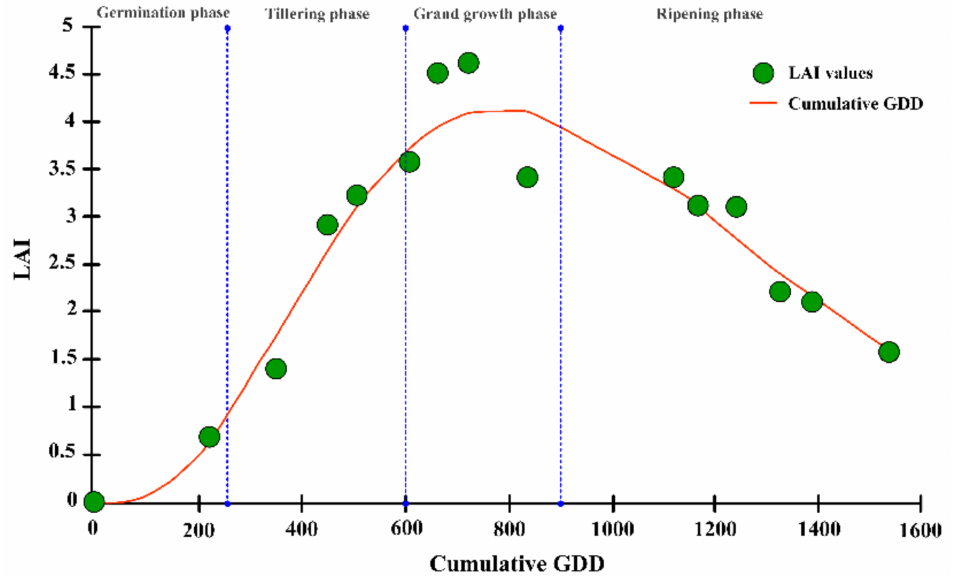
Figure 4. LAI at first ratoon of sugarcane crop compared to cumulative growing degree days (GDD) in different sugarcane growth phases (modified from Teruel et al. [98]). Green dots represent LAI values from observations, while the red line is cumulative GDD in units of degrees Celsius ( ◦